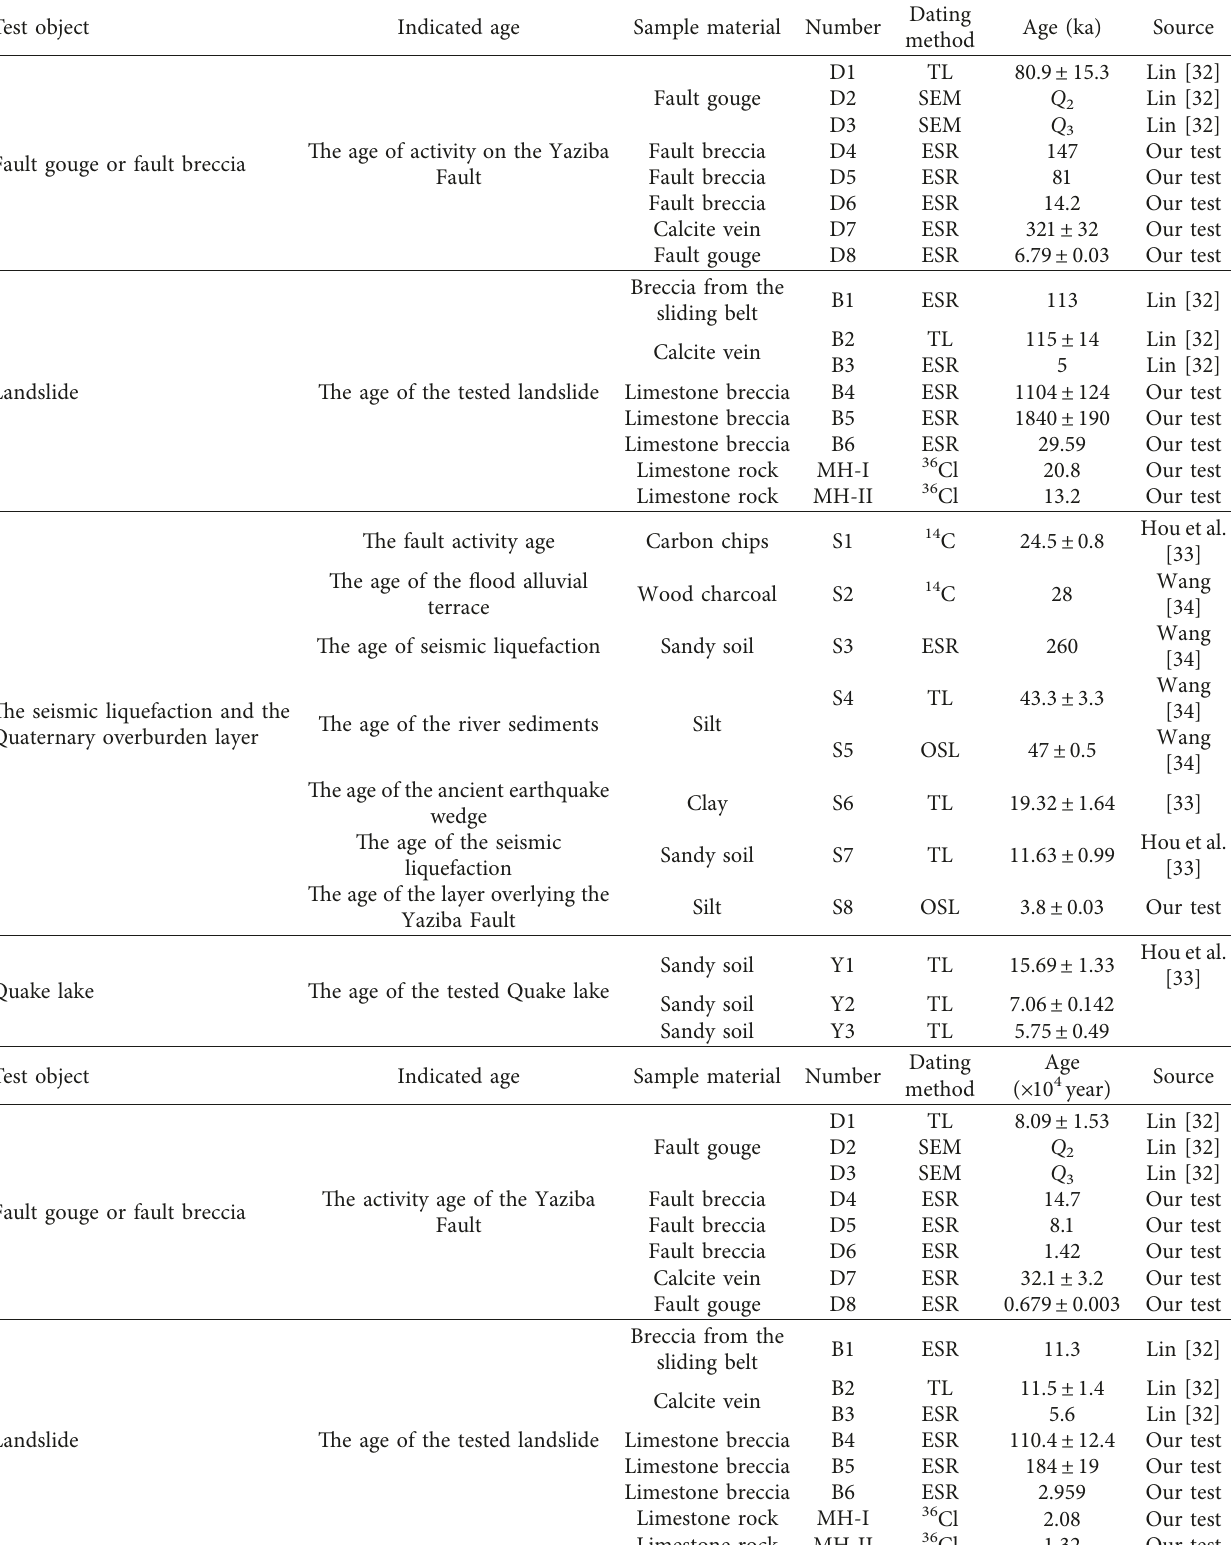
Table 1: Age dates for the area around the Yaziba